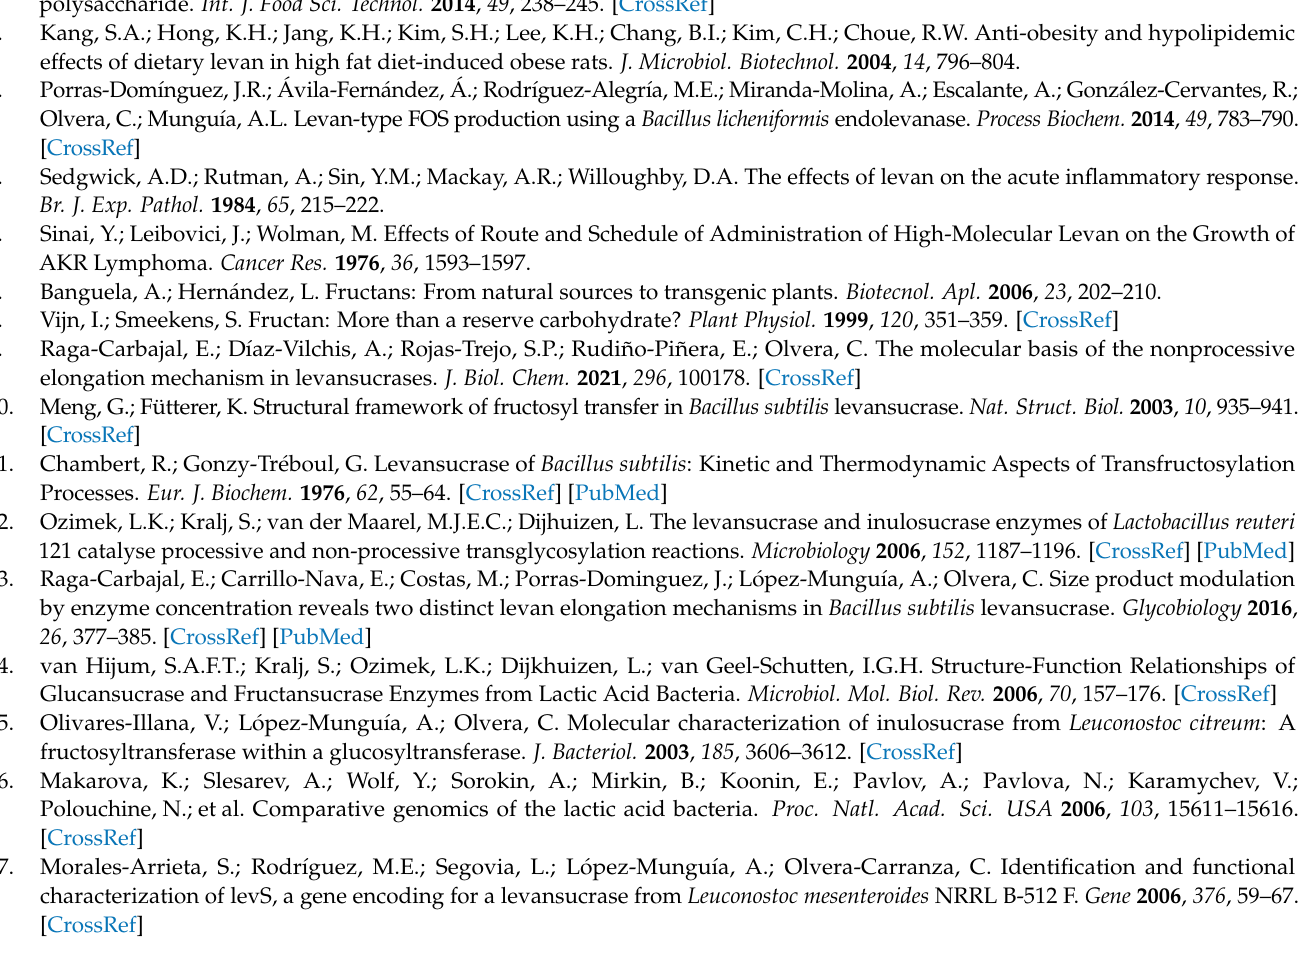
Table S1: Primers used in this study. NcoI restriction site is